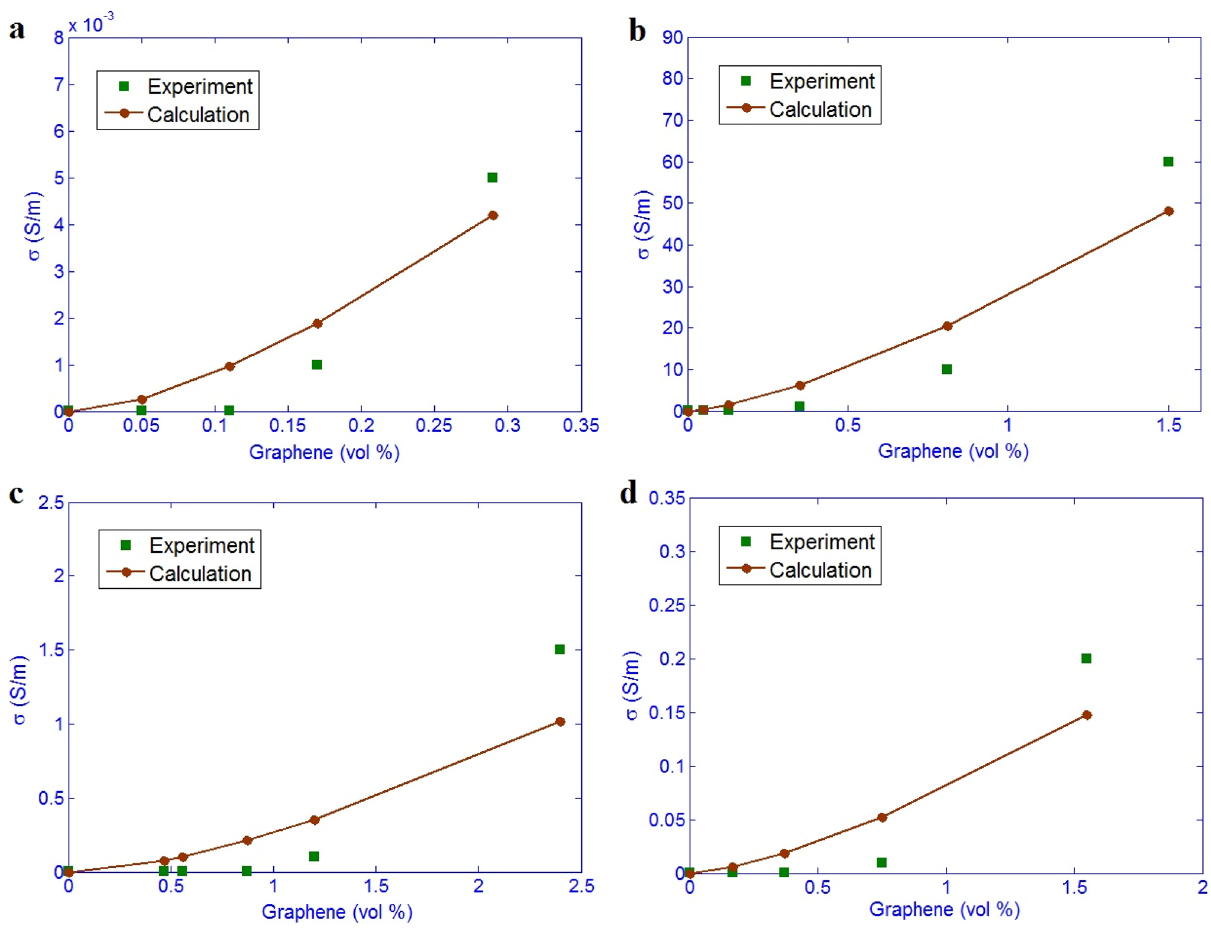
Figure 3. Relationship between experimented and theoretical results for ( a ) PI/graphene from Ref. 46 , ( b ) PS/ graphene from Ref. 47 , ( c ) PET/graphene from Ref. 48 and ( d ) SAN/graphene from Ref. 49